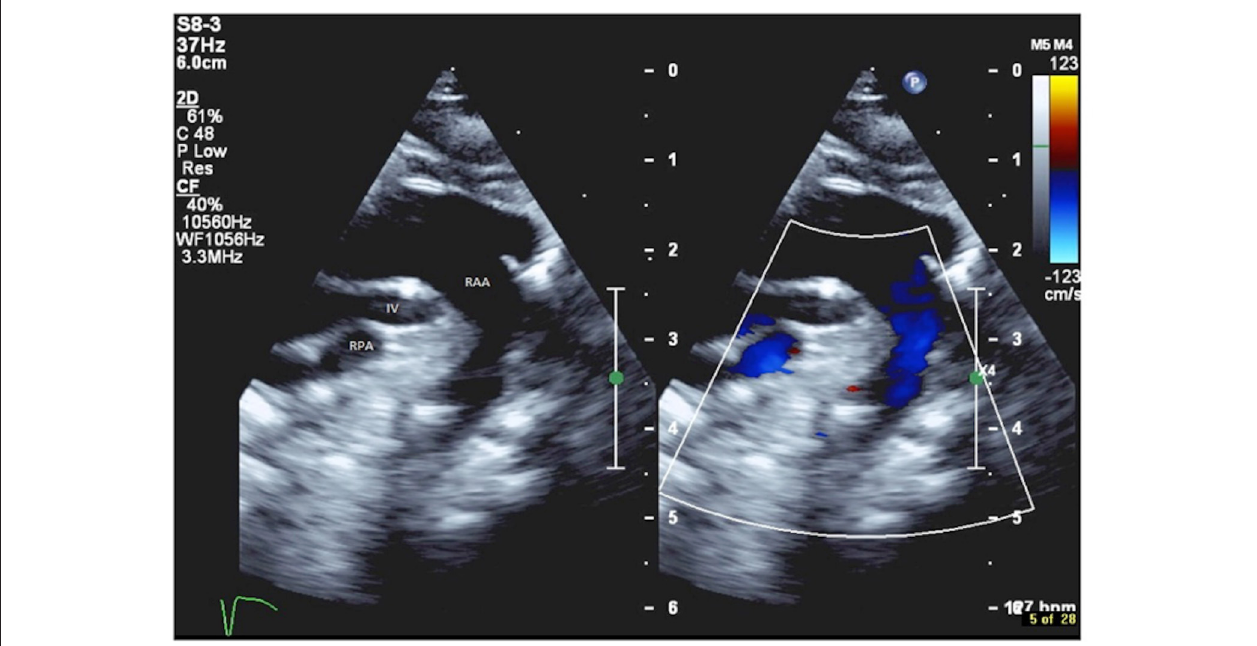
FIGURE 1 | Echocardiography showing the retro-aortic position of the innominate vein (IV), positioned between the right aortic arch (RAA) and the right pulmonary artery